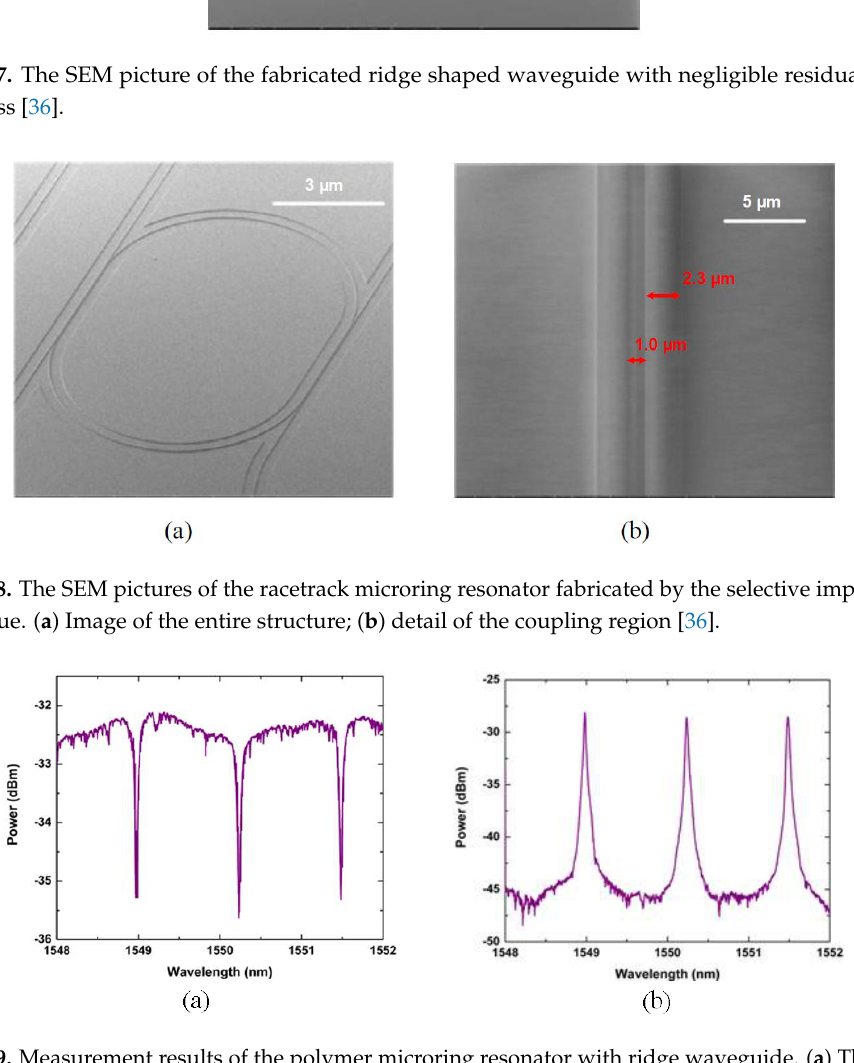
Figure 9. Measurement results of the polymer microring resonator with ridge waveguide. ( a ) Through port; ( b ) drop port.